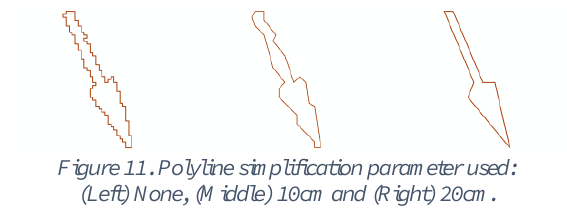
Figure 11. Polyline simplification parameter used: (Left) None, (Middle) 10cm and (Right) 20cm.